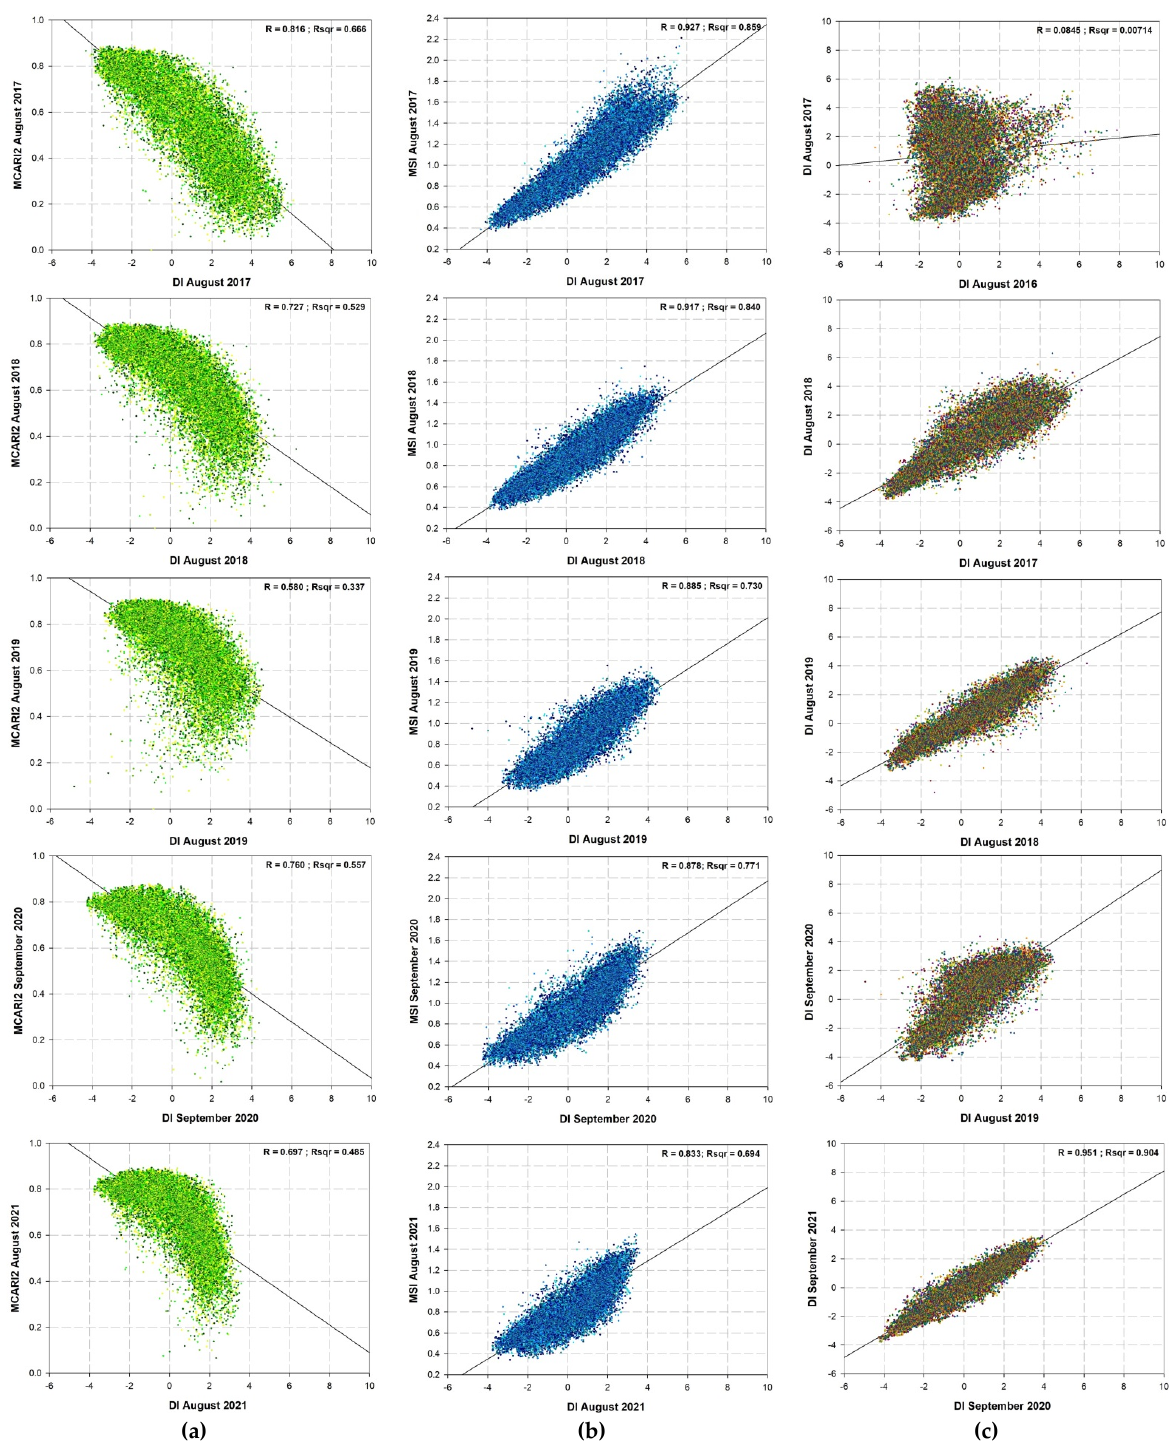
Figure 4. Linear regression analyses between DI and MCARI2 (a); DI and MSI (b); and DIs for two consecutive years (c) for the period between 2017 and 2021.